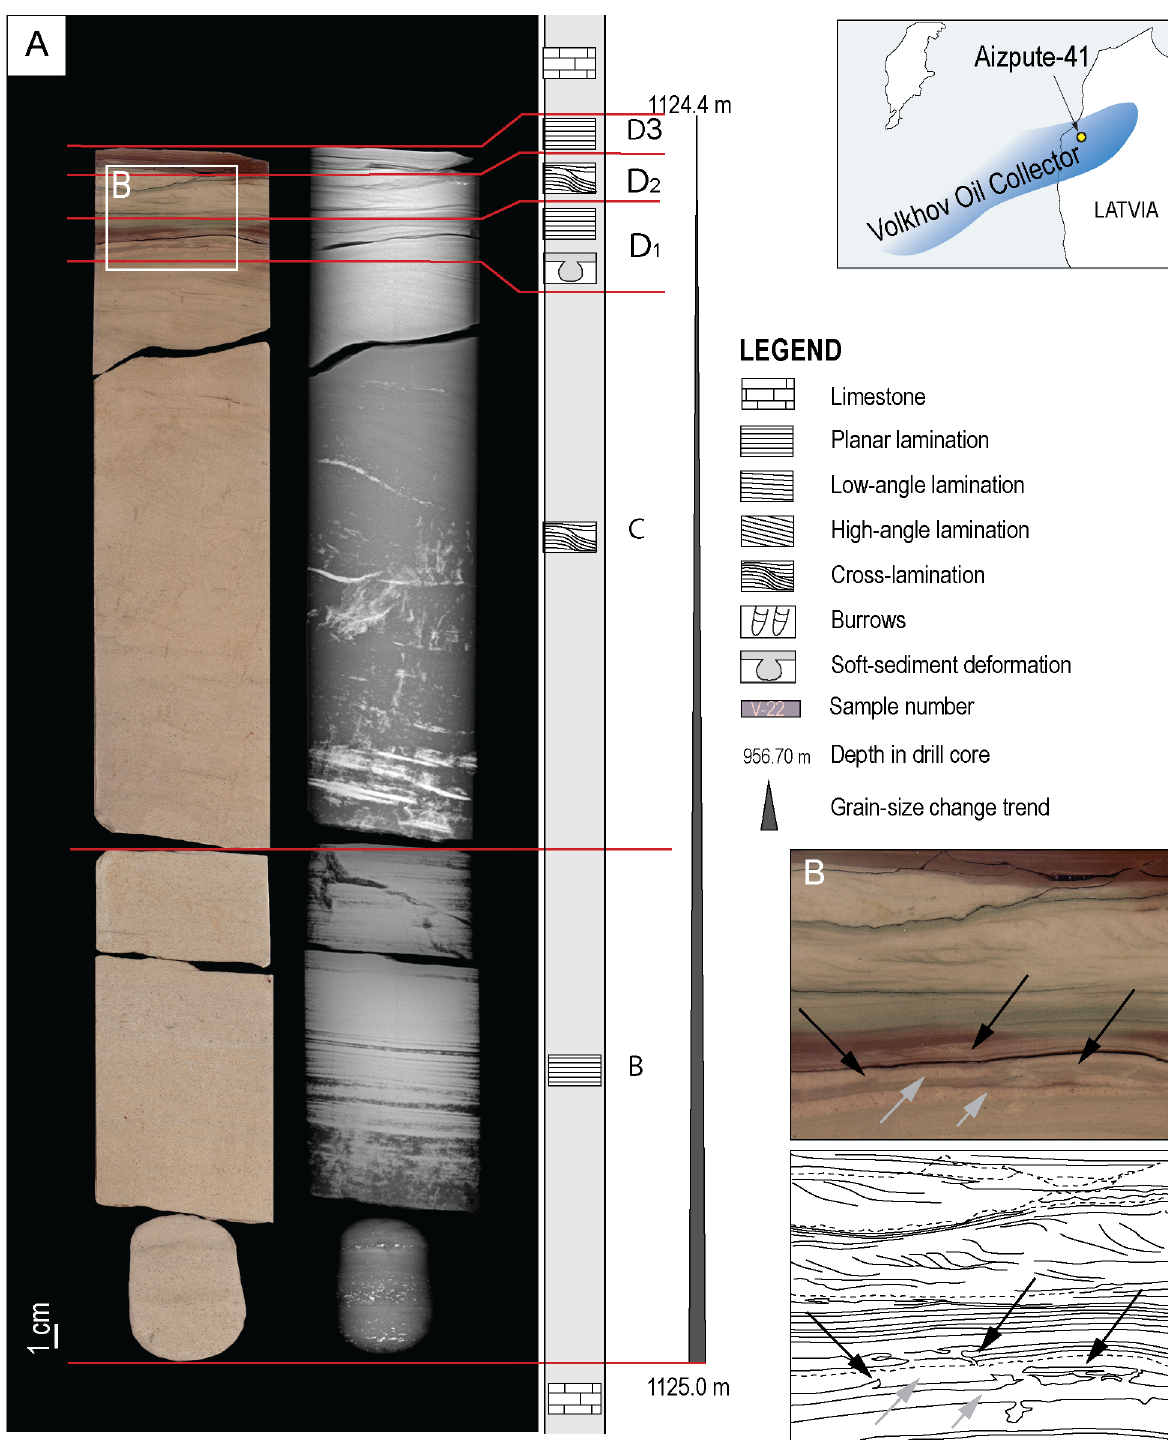
Fig. 5. The Volkhov Oil Collector in the Aizpute-41 drill core. A , a colour photograph (left) and X-ray radiograph (right) of the collector bed. B , close-up and line drawing of small sedimentary features in the upper part of the collector bed. Soft-sediment deformation features are indicated by black arrows, and grey arrows point to thin layers of liquefied sediment in between the distorted